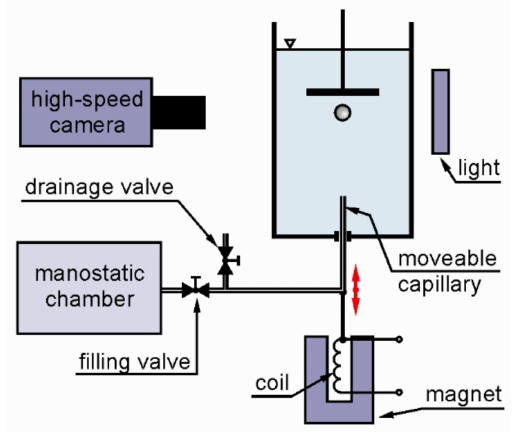
Figure 1. Experimental setup. Table 1. Physical-chemical properties of all used liquids. The dynamic surface tension corresponds to the moment of the first contact of the bubble with the solid surface. The bubble aging time corresponding to this moment varies in dependence on the bubble size and the corresponding